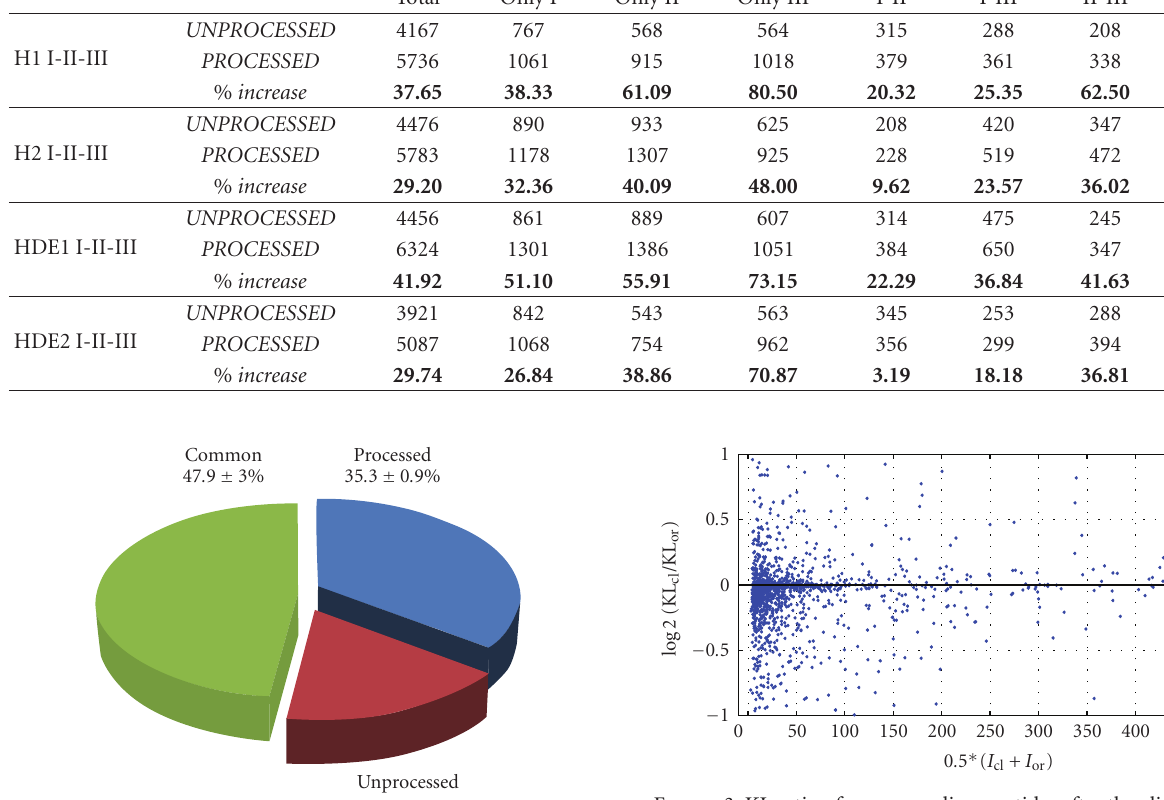
Figure 3: KL ratio of corresponding peptides after the alignment of the processed and the unprocessed maps of HDE2III. Most of the peptides have KL Clean < KL Original